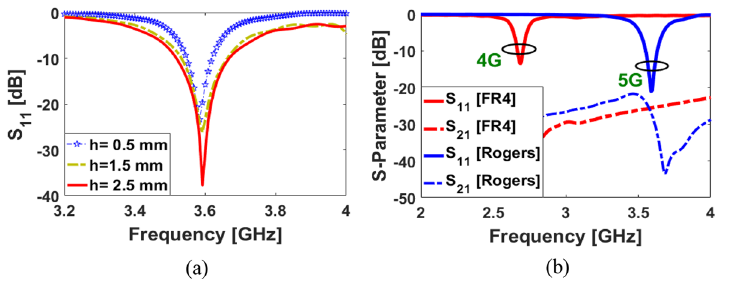
Figure 5. S 11 results for various sizes of ( a ) h, and ( b ) the substrate types.